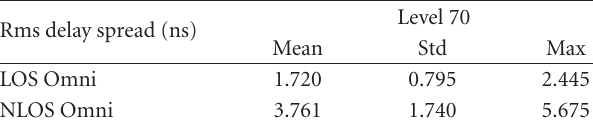
Table 5: RMS delay spread in LOS and NLOS cases with omnidi- rectional